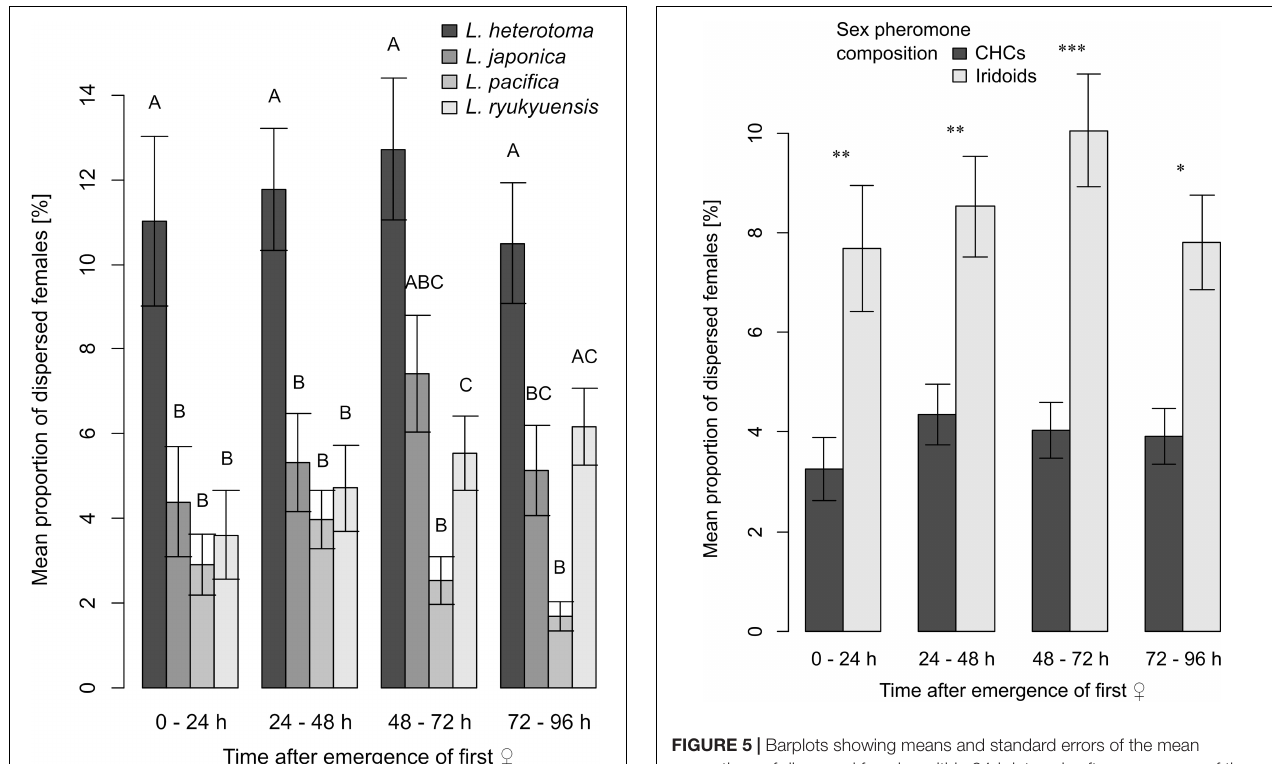
FIGURE 5 | Barplots showing means and standard errors of the mean proportions of dispersed females within 24-h intervals after emergence of the first female in each jar for species using CHCs ( L. pacifica and L. ryukyuensis , dark gray bars) or iridoids ( L. heterotoma , L. japonica, light gray bars) in the female sex pheromone. Dispersal in each time interval was compared with Wilcoxon signed rank tests (Bonferroni corrected). Asterisks indicate a significant difference * P < 0.05, ** P < 0.01, *** P < 0.001. For each experiment, N =